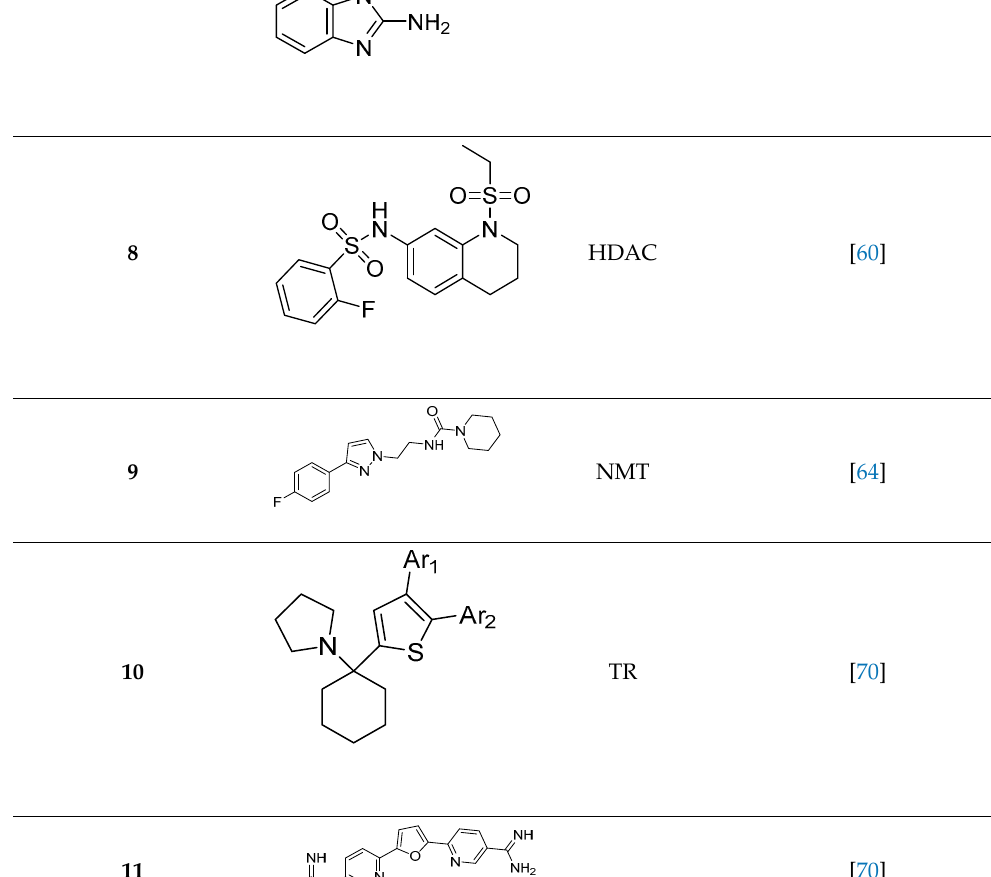
Molecules 2021 , 26 ,